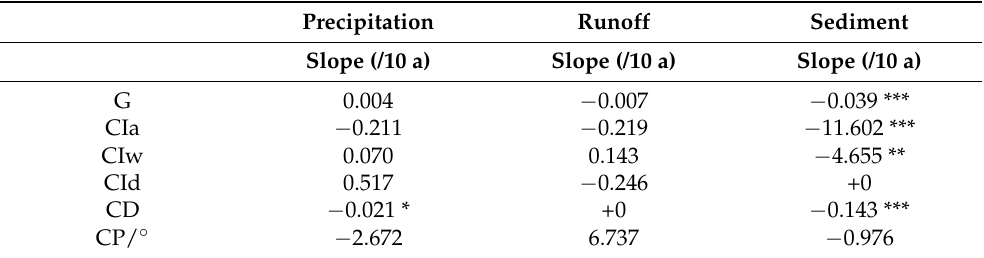
Table 4. The trends in the precipitation, runoff, and sediment concentration indices for the Daning River basin.